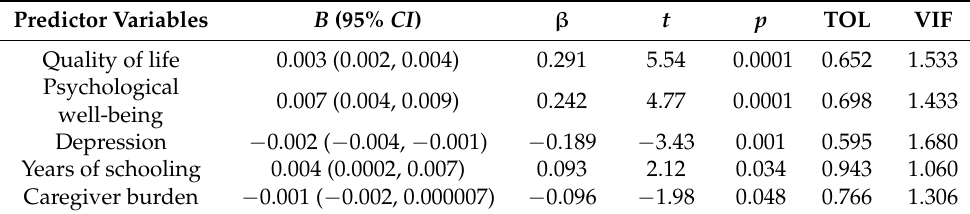
Table 4. Regression model predicting resilience in family caregivers, Sample size ( N ) =